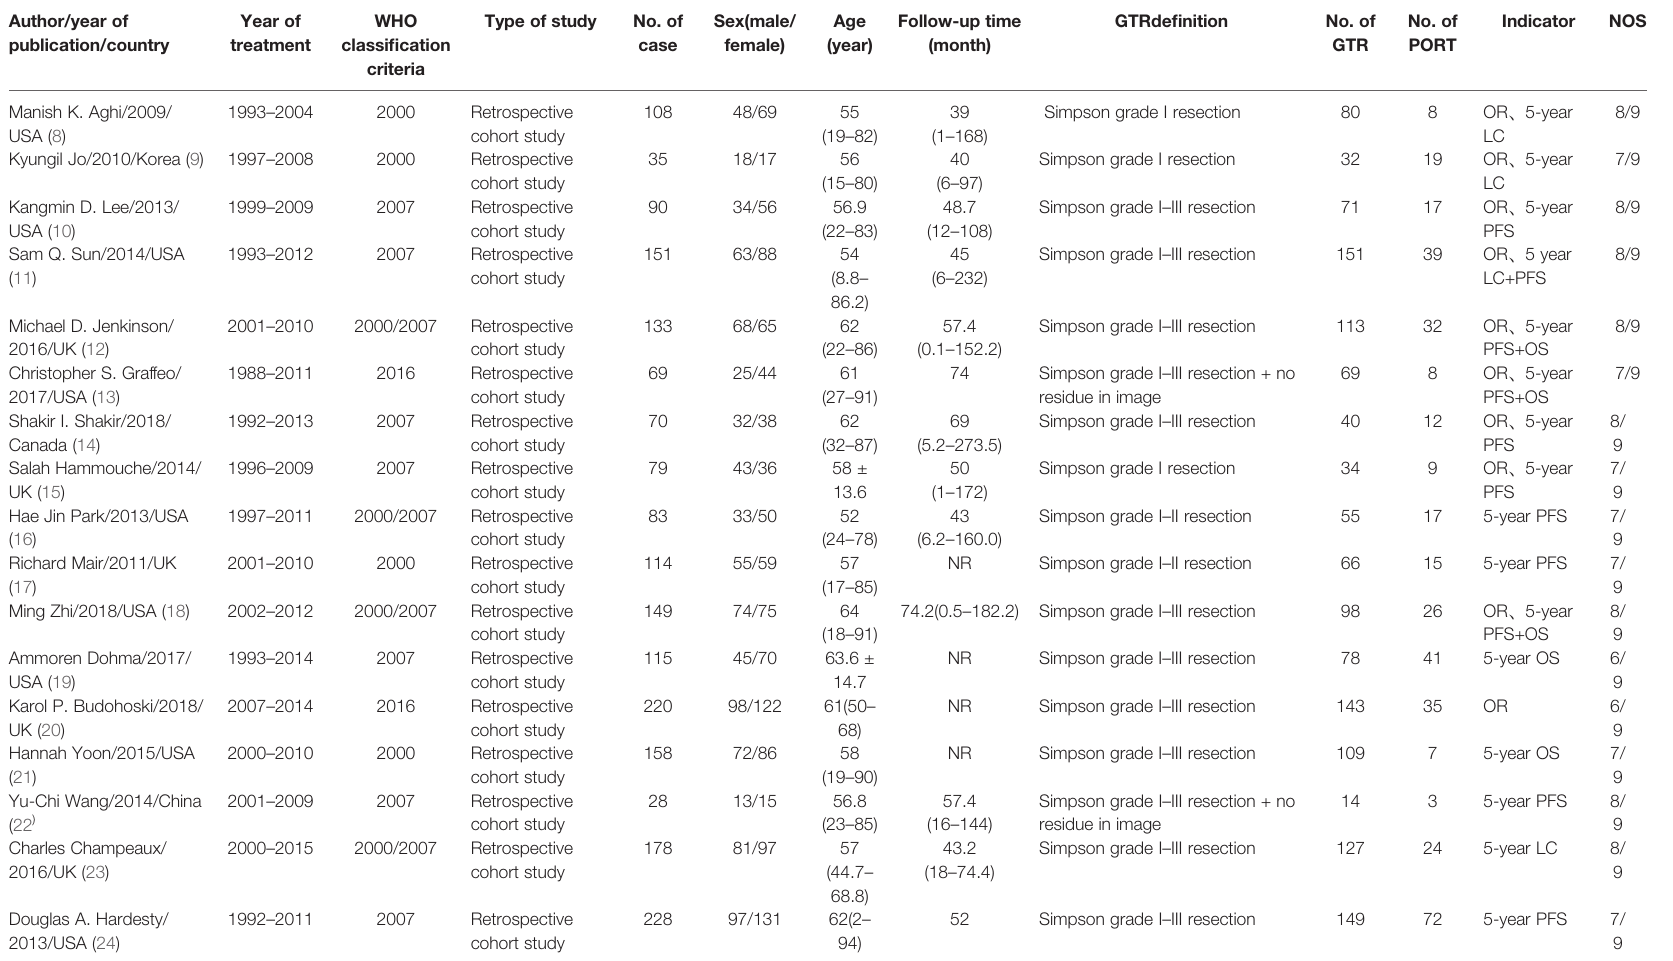
TABLE 1 | Characteristics of studies for association between PORT and